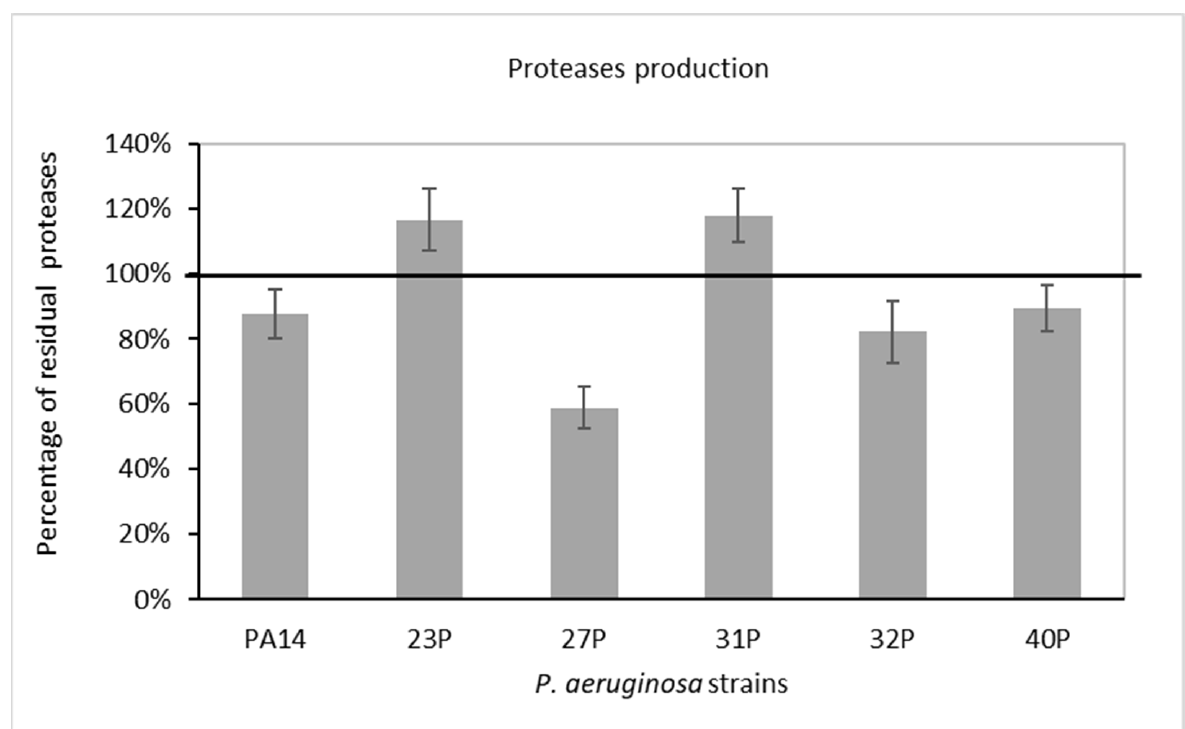
Figure 4. Effect of SN_TAE2020 on protease production after 48 h of incubation. Data are reported as the percentage of residual proteolytic activity after the SN_TAE2020 treatment in comparison with that of controls (bacteria grown in the presence of Gut diluted 1:5). Each data point is composed of 4 independent experiments, each performed in at least 3 replicates.